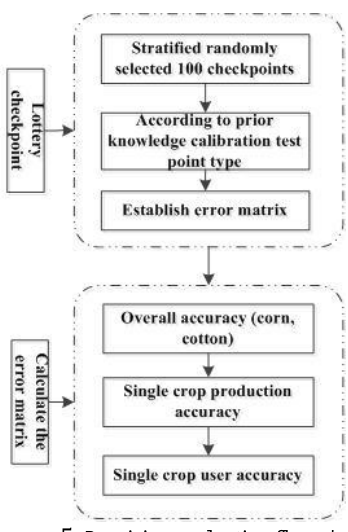
Figure 5. Precision evaluation flow